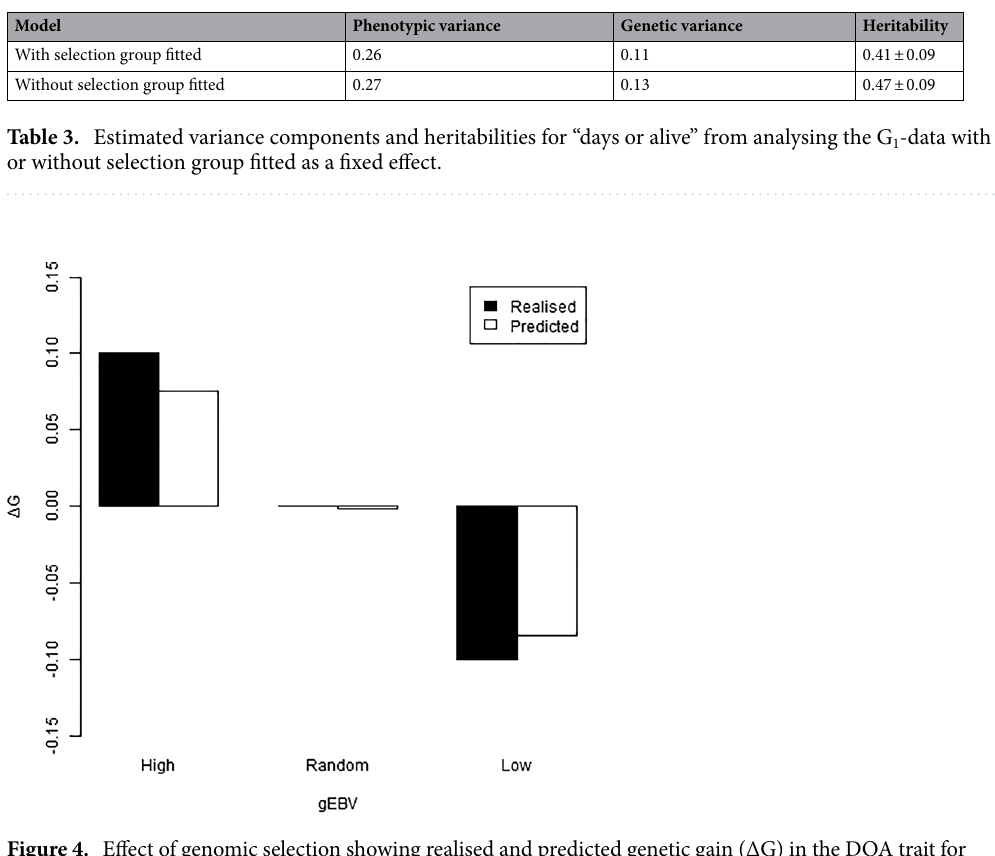
Figure 4. Effect of genomic selection showing realised and predicted genetic gain (ΔG) in the DOA trait for high, random and low gEBV selection